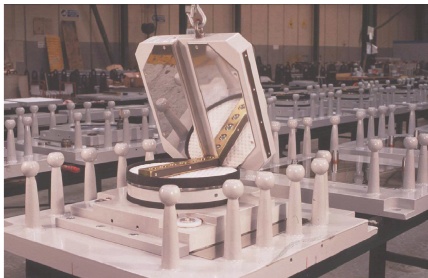
Figure 2: Steel damping bearings used in the Caracas–Tuy Medio